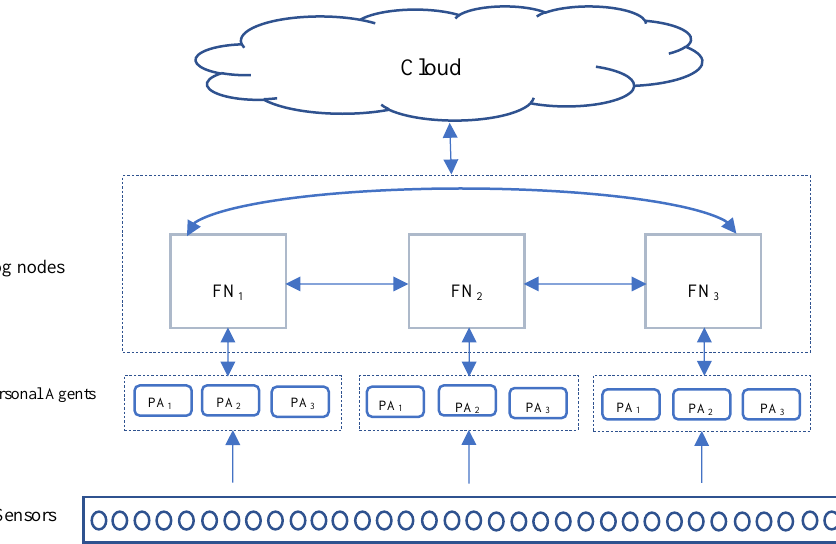
Figure 3. The flow of tasks from sensors to Cloud.